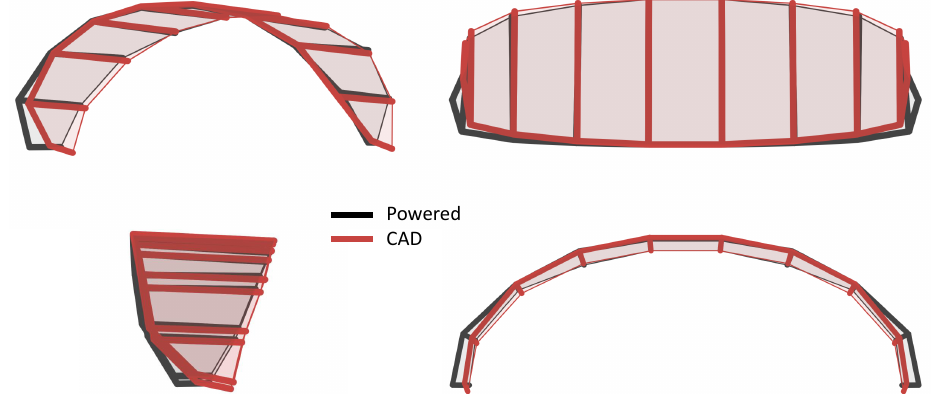
Figure 8. In black, the wing shape in a fully powered state ( u p = 1), and in red, the shape of the CAD model, displayed in an orthographic view ( top left ), a top view ( top right ), a side view ( bottom left ), and a front view ( bottom right )